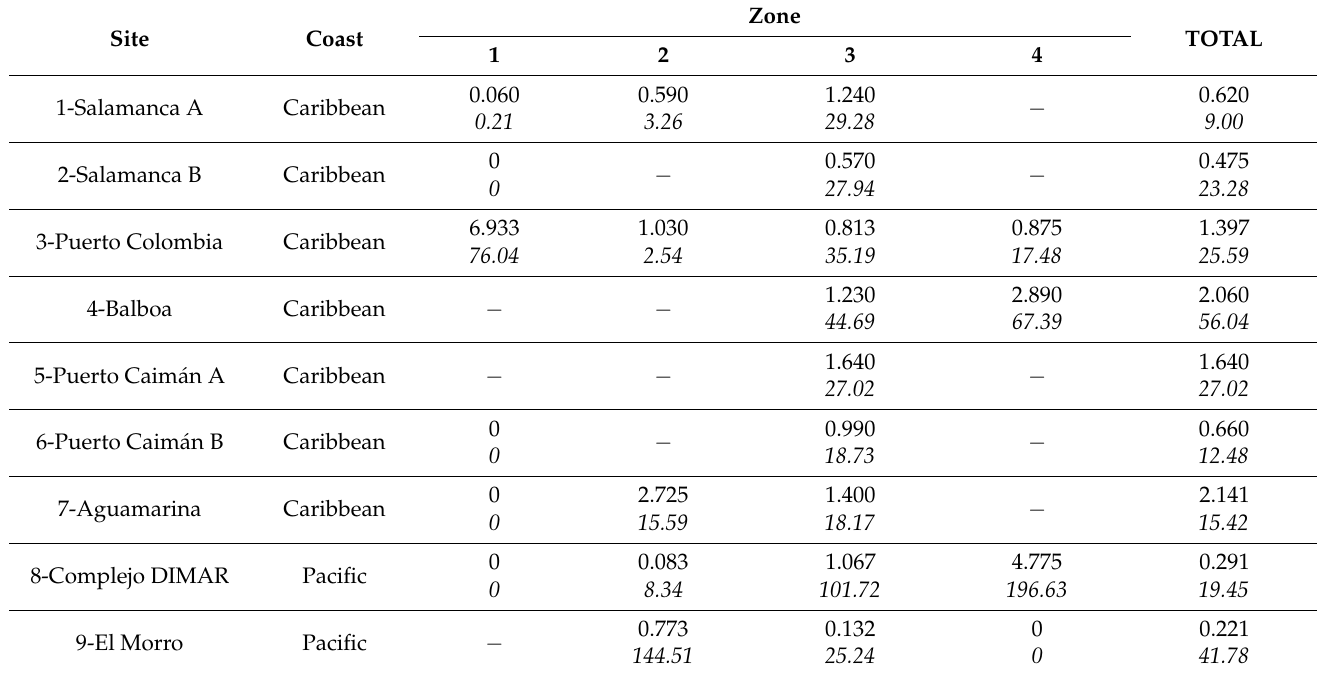
Table 2. Abundance (items/m 2 ) and weight (g/m 2 ) per zone and site. The four zones investigated are reported in Figure 1. Total values were calculated per site, considering the total number of